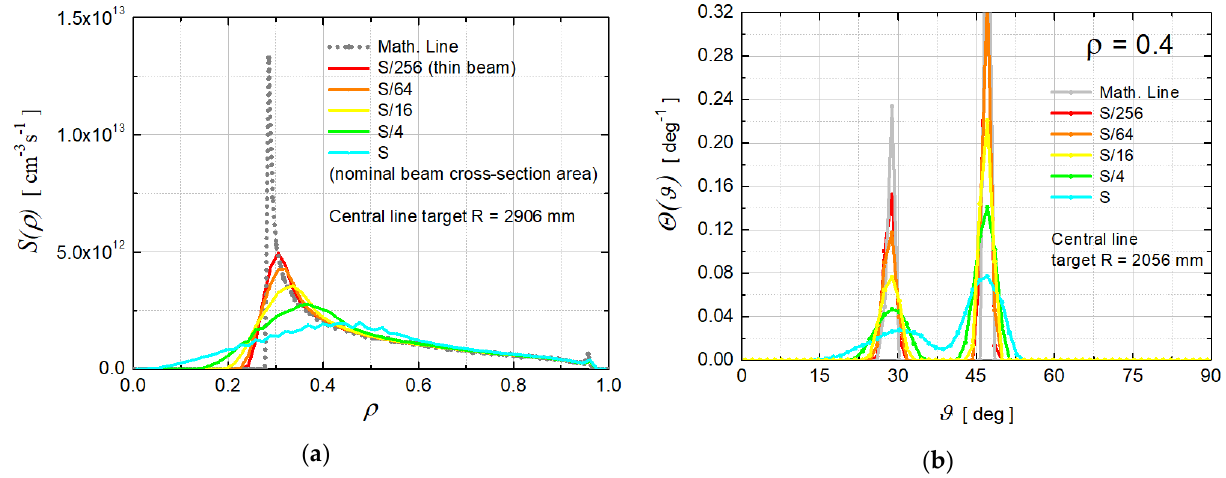
Figure 12. ( a ) Verification of the source function of fast ions produced by the neutral beam with tangency radius R = 2906 mm; ( b ) Verification of the angular distribution of the source of fast ions produced by the neutral beam with tangency radius R = 2056 mm.